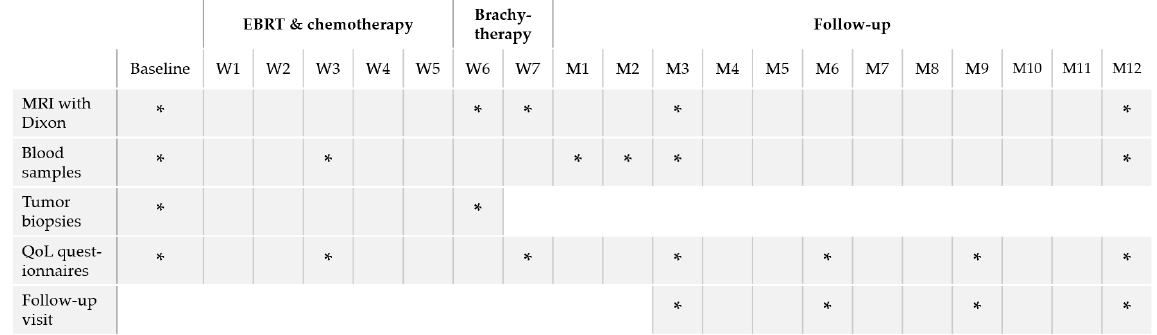
Figure 4. Overview of data collection points per patient enrolled in the PROTECT trial. *, data collection point; EBRT, external beam radiation therapy; W, week; M, month; MRI, magnetic resonance imaging; QoL, quality of life.